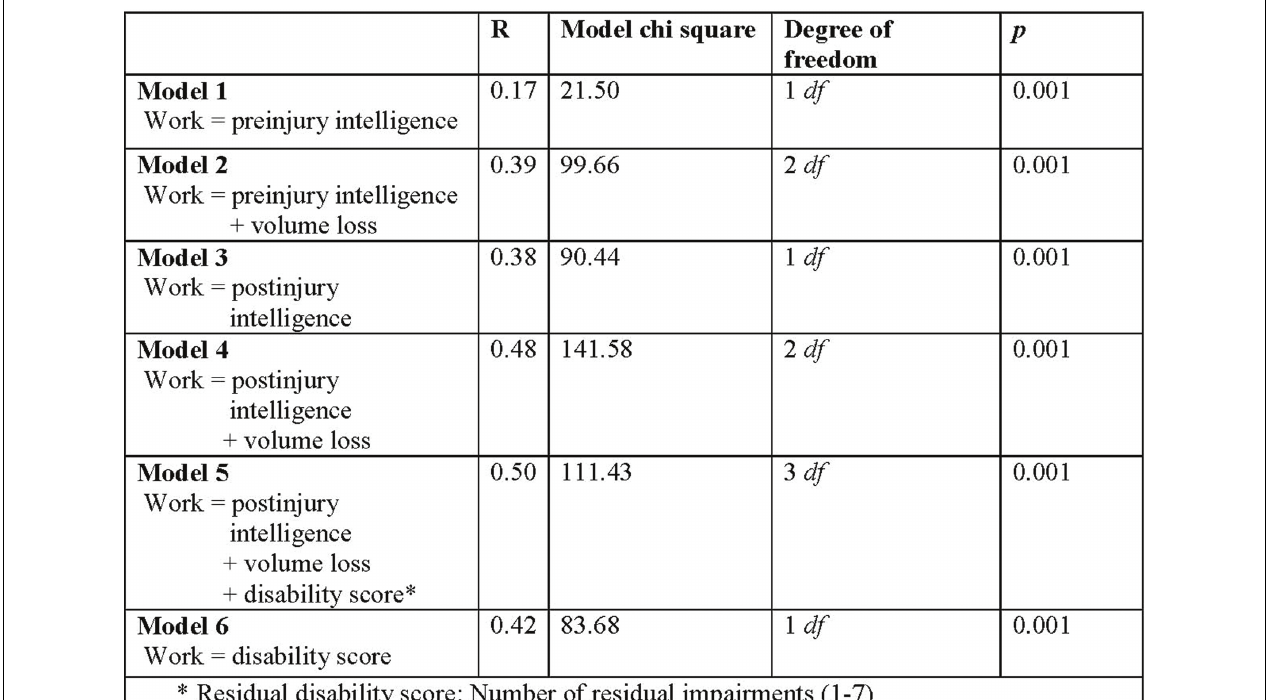
FIGURE 5 | Logistic regression analysis outcomes for predictive factors of variation in work status.